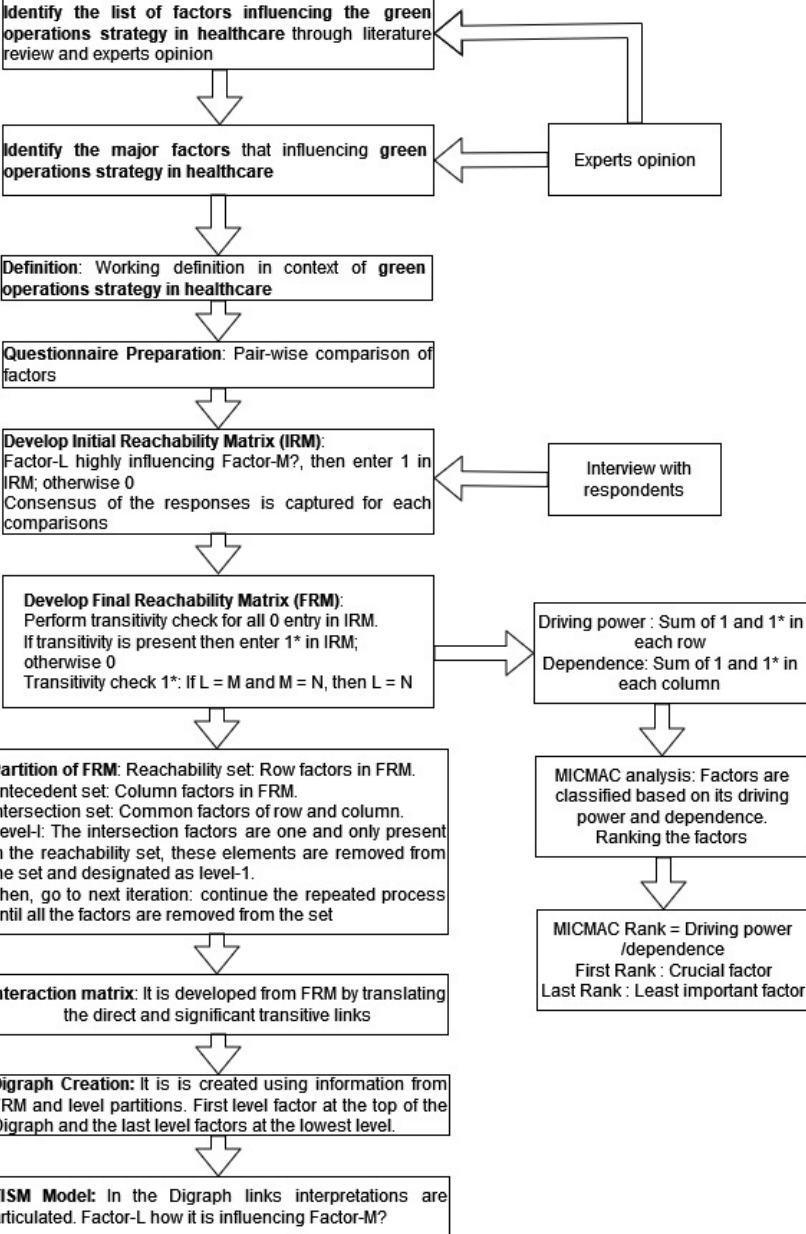
Figure 1. Flow of the total interpretative structural model approach for green operations strategies in healthcare.